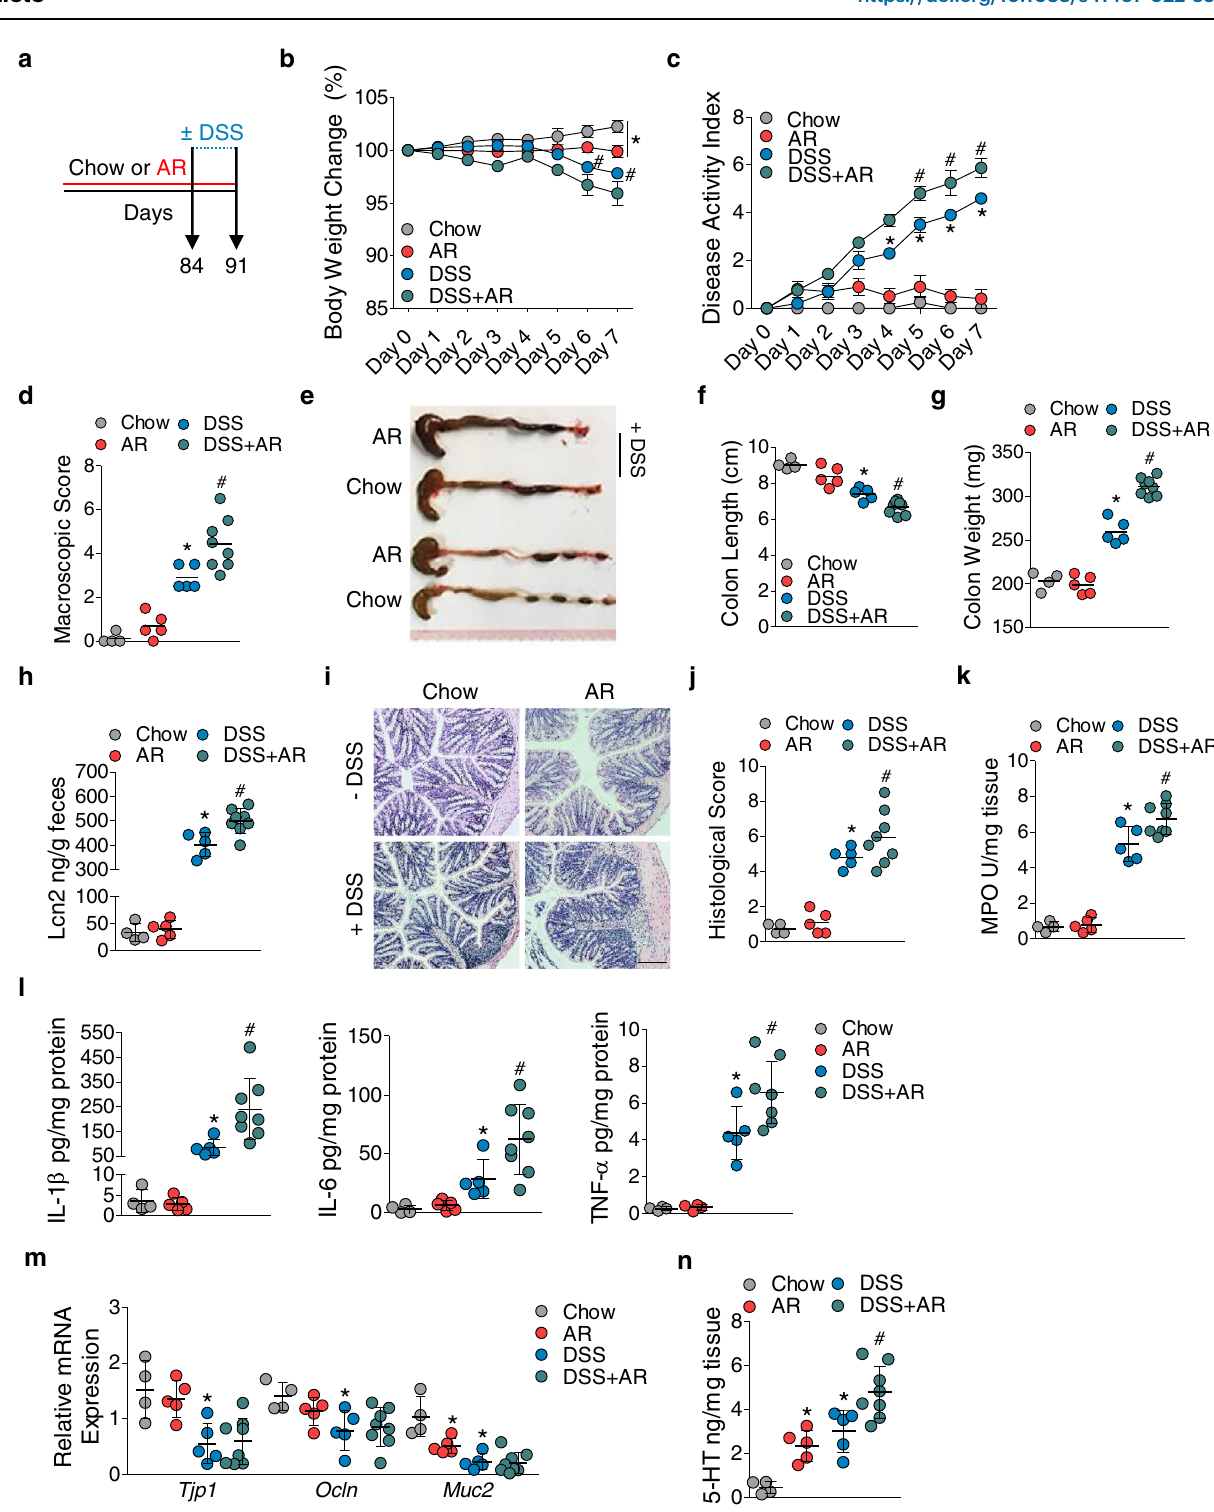
Fig. 1 | Exacerbation of DSS-induced colitis by AR exposure in C57BL/6 mice. C57BL/6micewereeitherfednormalchowdietorexposedto100ppmARviadiet for 12 weeks (84 days) prior to induction of acute colitis by 3.5% DSS for 7 days. DuringDSS,micewerecontinuouslyexposedtoAR. a Schematicillustrationofthe experimental design. b Body weight changes during DSS. c Disease activity index (DAI)duringDSS. d Macroscopicscore. e Arepresentativeimageofcolons. f Colon length (cm). g Colon weight (mg). h Fecal LCN2 levels. i Representative images of hematoxylin and eosin (H&E)-stained colon sections on day 7 post DSS; scale bar: 100 µ m. j Histological score. k Colonic MPO levels. l Colonic IL-1 β , IL-6, and TNF- α